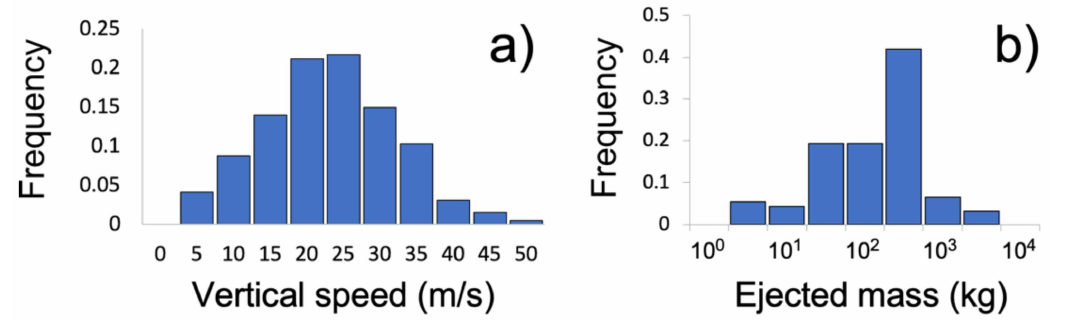
Figure 7. ( a ) Distribution of vertical exit speeds of the sequence of explosions. The four largest explo- sions are not considered in the computations. ( b ) Distribution of mass erupted in single